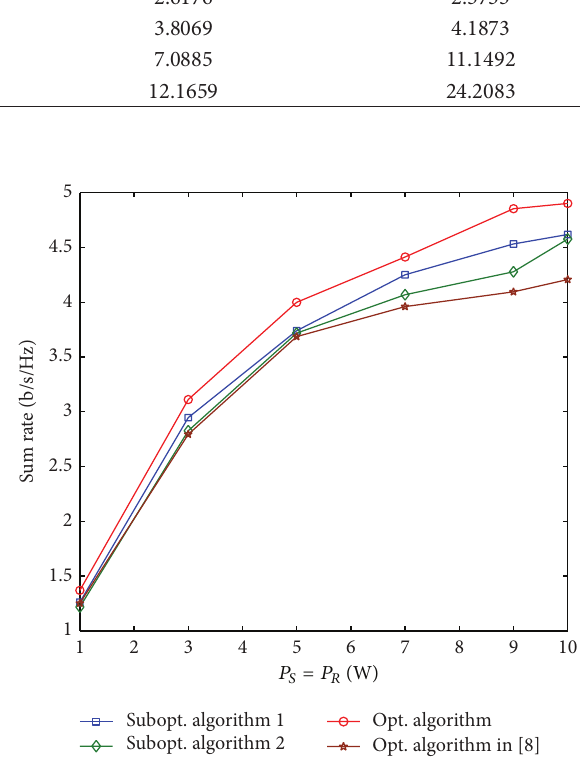
Figure 5: Sum rate versus 𝑇 1 . Figure 6: Sum rate versus the total